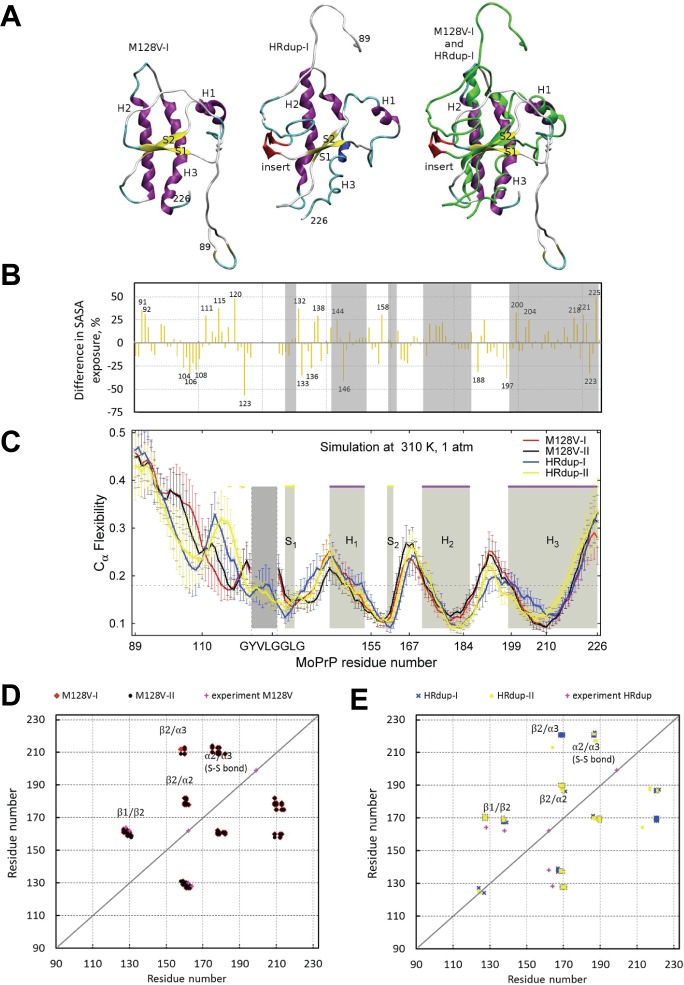
Molecular dynamics assessment of HRdup PrP.A) Representative conformations from 20ns molecular dynamics runs for M128V and HRdup PrP. α-helices are colored with magenta, β-strands with yellow, turns with cyan, random coils are white and the insert (for HRdup) is red. For the alignment, regions in HRdup that show differences with respect to M128V are depicted in green, and the insert is indicated in red. B) Differences in weighted average per-residue SASA for HRdup versus M128V models were averaged over two trajectories per allele (positive or negative differences indicate, respectively, greater or lesser solvent exposure in HRdup in comparison with M128V, as listed in the last column of S5 Table). Positions of helices and beta strands are shaded in grey (see also panel C). C) Main chain flexibility profiles in the PrP systems. For M128V, the flexibility profile is shown with red and black lines, and for systems with insert the profiles are shown with yellow and blue lines. The insert area is marked with vertical dashed lines. The main secondary structure elements in PrP are shaded in grey are indicated at the top of the plots with purple lines for α-helices and yellow lines for β-strands. Panels D) and E): The strongest correlations of non-consecutive residues from ECD pair correlation maps of the four PrP systems, as listed in S5 Table. D) Data for M128V-I (red dots) and M128V-II (black dots); E) Data for HRdup-I (blue crosses) and HRdup-II (yellow crosses). The regions of strongest correlations S1-S2, S2-H2, S2-H3, and H2-H3 are indicated. Correlations S1-S2 determined from 2D NOESY experiments are shown with magenta crosses in D and E.